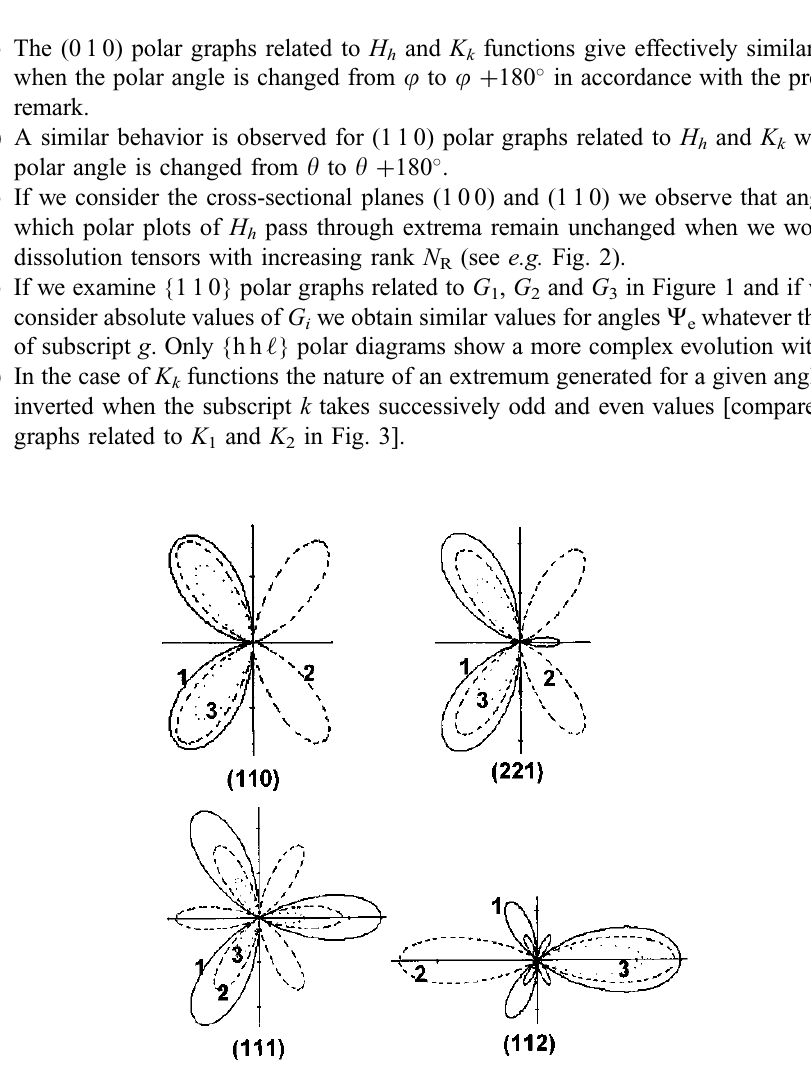
FIGURE 1 Polar plots (in arbitrary units) of functions G 1 (full lines), G 2 (broken lines) and G 3 (dotted lines) in various cross-sectional planes as indicated in figures. The factor of amplification for functions G 2 and G 3 with respect to function K 1 is equal to 5 and 20,